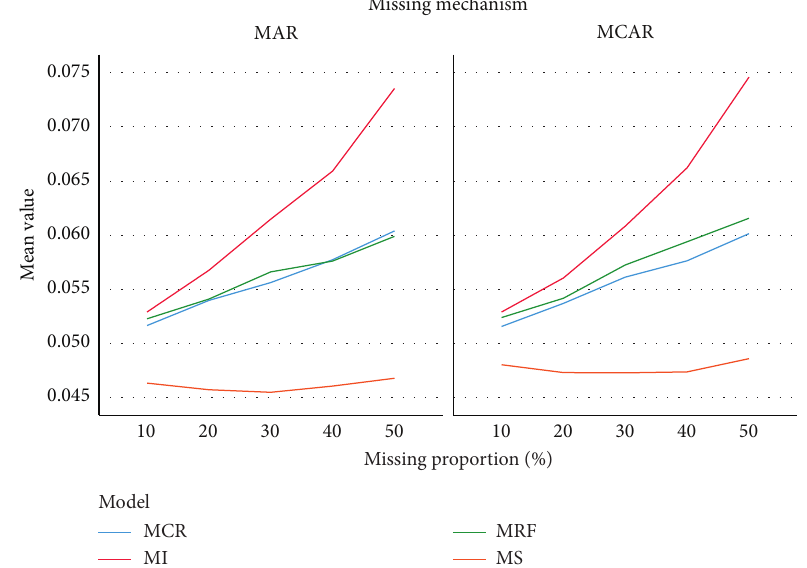
Figure 4: Comparison of the performance of imputation methods for real dataset based on the model SE for the interaction effect. MAR, missing at random; MCAR, missing completely at random; MCR, multiple imputation by chained equation using classification and regression trees; MRF, multiple imputation by chained equation using random forests; MI, MICE-Interaction method; MS, MICE-Stratified method.